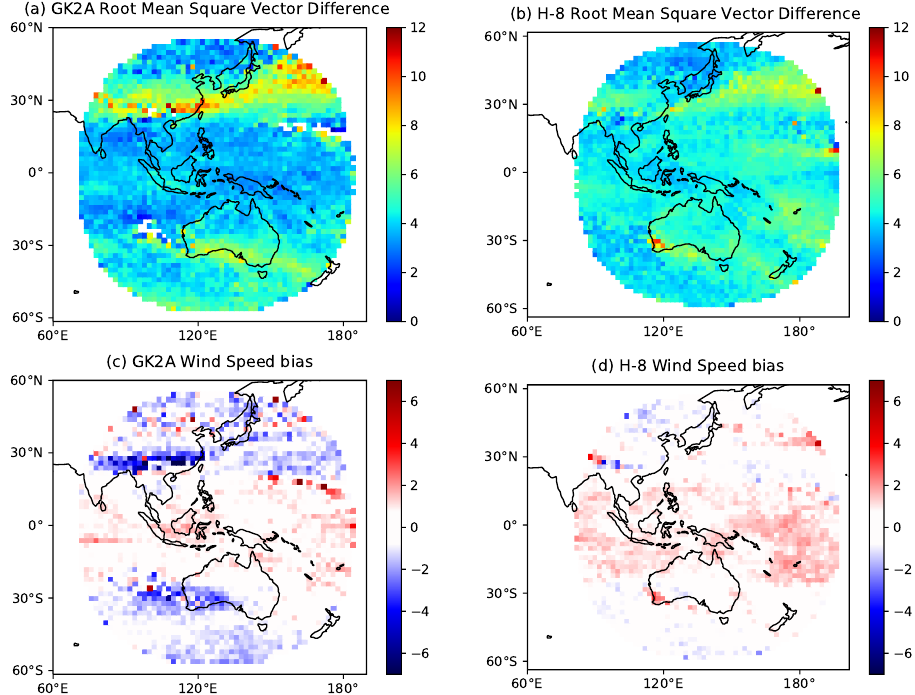
Figure 3. RMSVD ( a , b ) and wind speed bias ( c , d ) for IR winds at high level (<400 hPa) using winter data with GK2A data ( a , c ) and H-8 data ( b , d